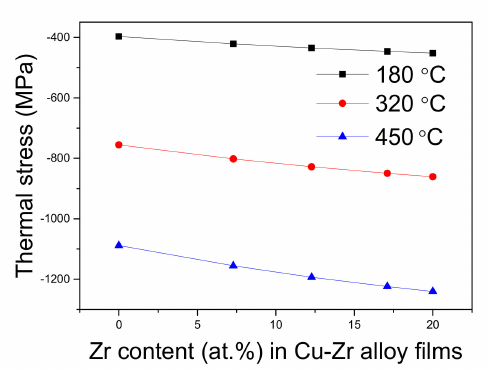
Figure 12. ThermalstressasafunctionofZrcontentforCu–Zrfilmsannealedatthreedifferenttemperatures.